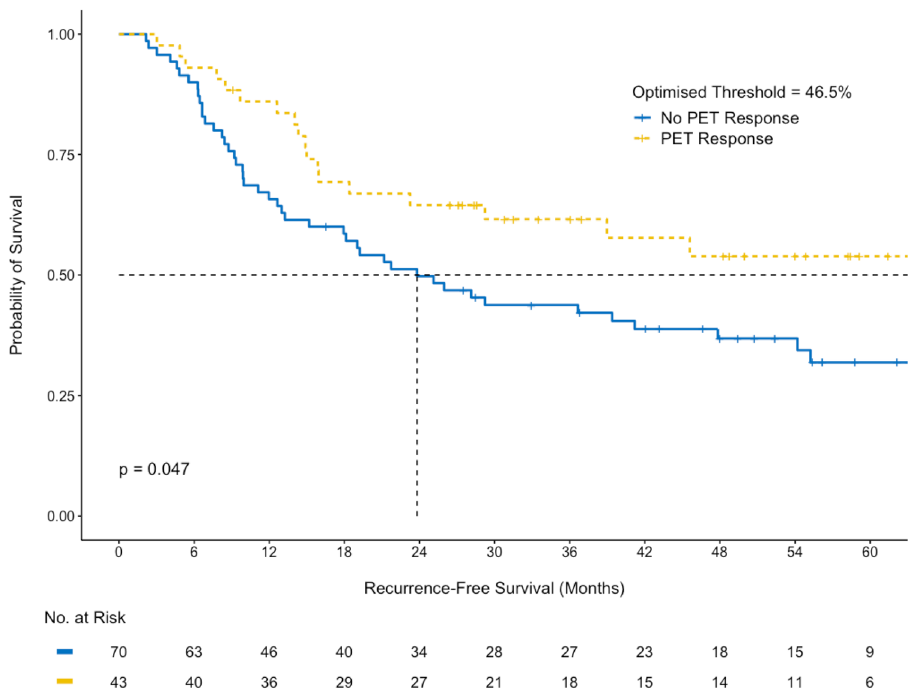
Figure 6. Recurrence-free survival difference between pathological responders and non-responders using the optimised threshold of 46.5% reduction in